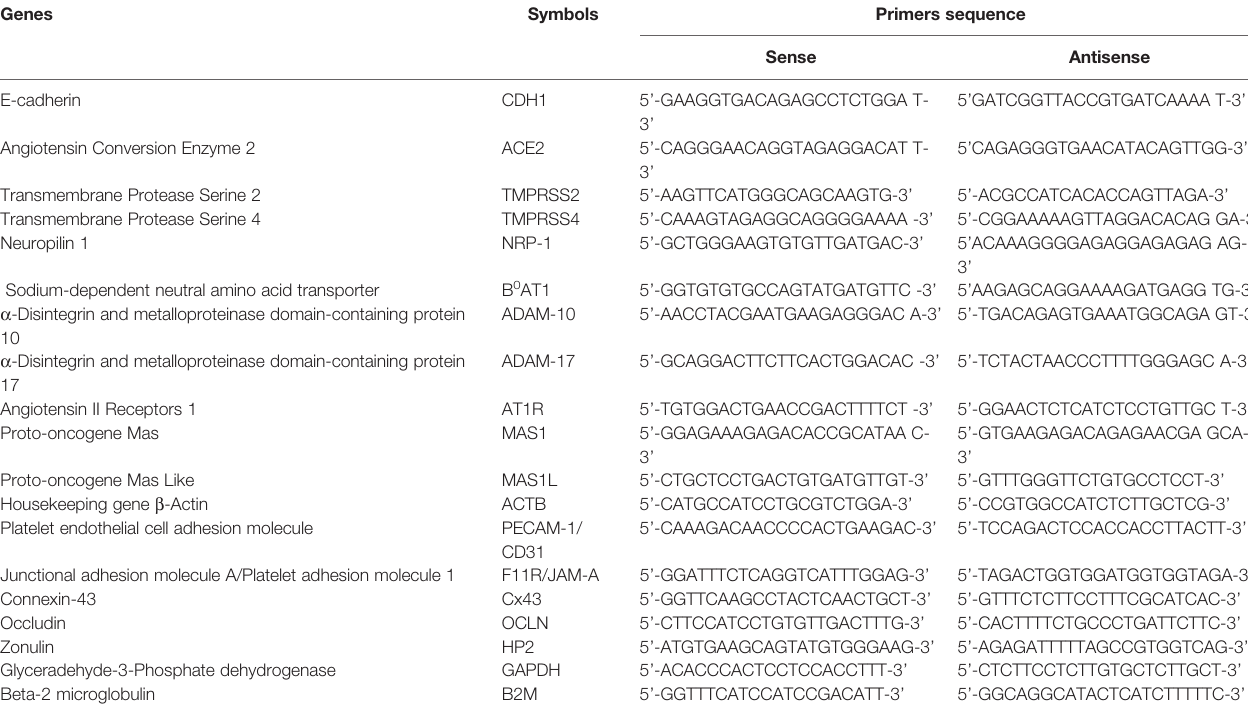
TABLE 1 | Primers sequences used for the